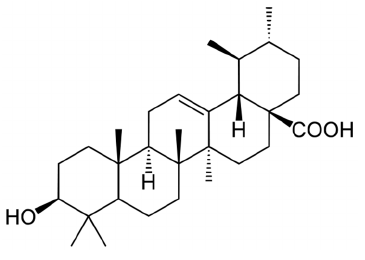
Figure 1. Structure of ursolic acid.